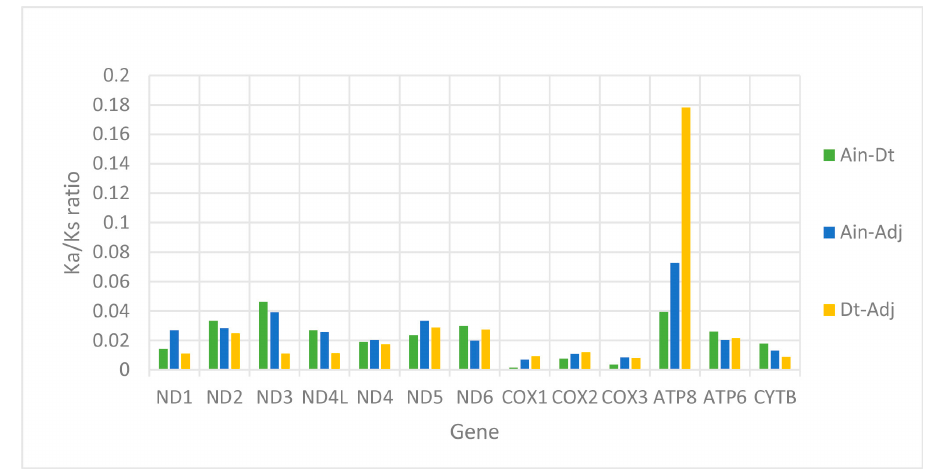
Figure 3. Evolutionary rates of the mitogenomes of Alectis indicus (Ain), Decapterus tabl (Dt), and Alepes djedaba (Adj). Note: The ratio of non-synonymous substitutions to synonymous substitutions (Ka/Ks) for each PCG is indicated.